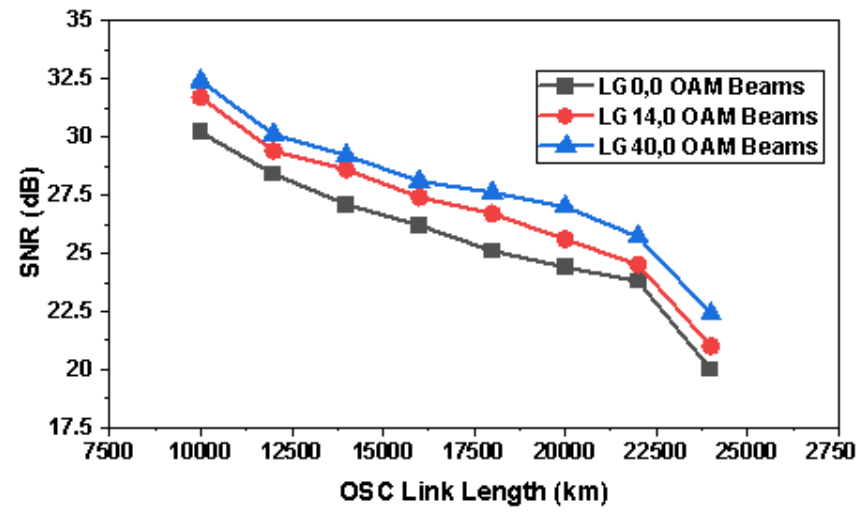
Figure 14. Representation of SNR versus OSC link lengths in the case of three OAM beams.